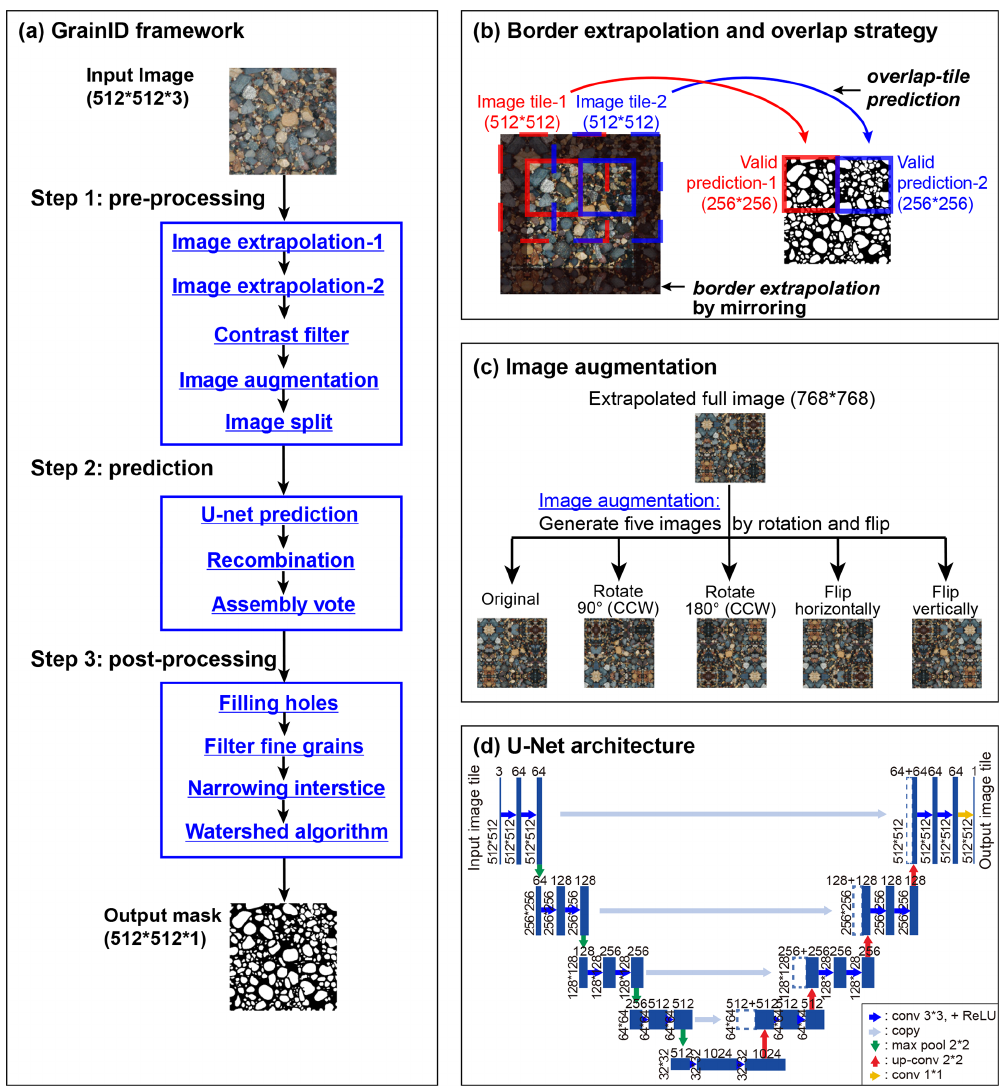
Figure 4. Framework and specific algorithms of GrainID: (a) GrainID framework; (b) border extrapolation and overlap-tile prediction; (c) image augmentation; and (d) U-Net architecture adapted from Ronneberger et al.